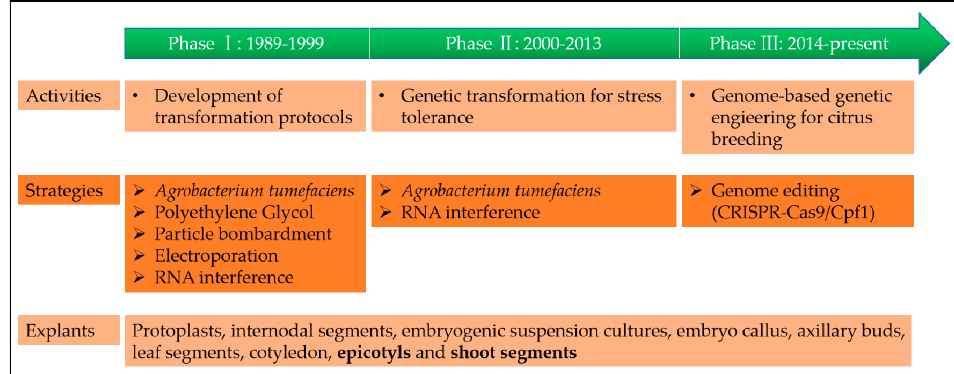
Figure 1. History of the genetic transformation of citrus.